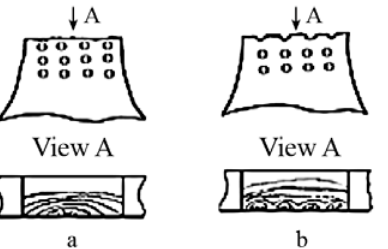
Fig. 5. Diagram of surface and fracture of samples with dimples, destroyed by fretting fatigue: а – destruction outside dimples; b – destruction within dimples Textured dimple surfaces ensure the reduction of abrasive wear of the steel 0.3C-Cr-Mn- Si surface layer by 37–38% due to absorption (removal) of abrasive particles and wear debris from the friction surface to the dimple. The destruction of the surface layers by abrasive particles is connected with their repeated influence and the damage accumulation in the surface layers of tribological contact and inner sides of dimples. The greatest wear is found for the far-end surface of the dimple, with respect to the direction of motion of abrasive particles. Counteraction to the penetration of abrasive particles in the distant surface will determine the level of abrasive wear of discrete areas and dimple surface as a